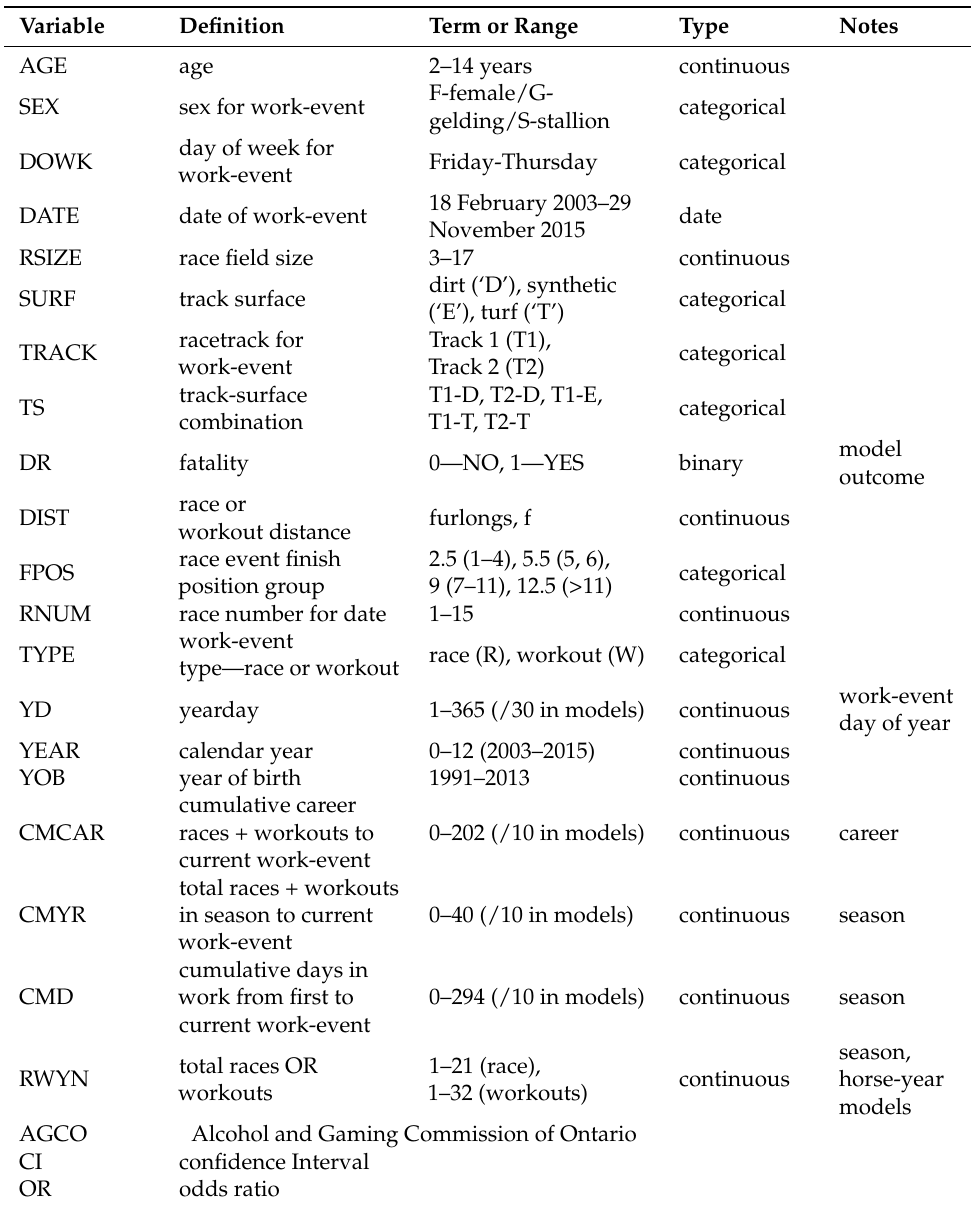
Table 1. Definition of abbreviations and variables used in analysis of fatality data for Ontario Thoroughbred horses,